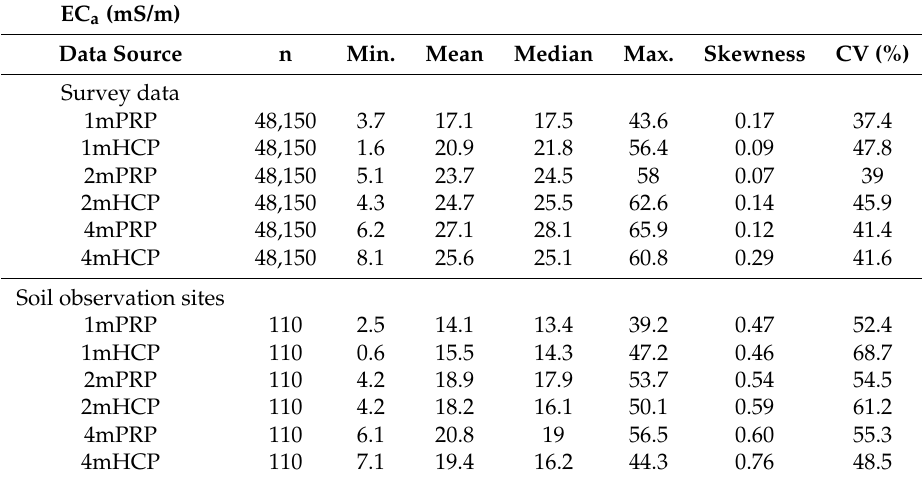
Table 1. Summary statistics for the apparent electrical conductivity (EC a —mS/m) measured by a DUALEM-421S for the whole survey area and at the soil observation sites. EC a (mS/m) Data Source n Min. Mean